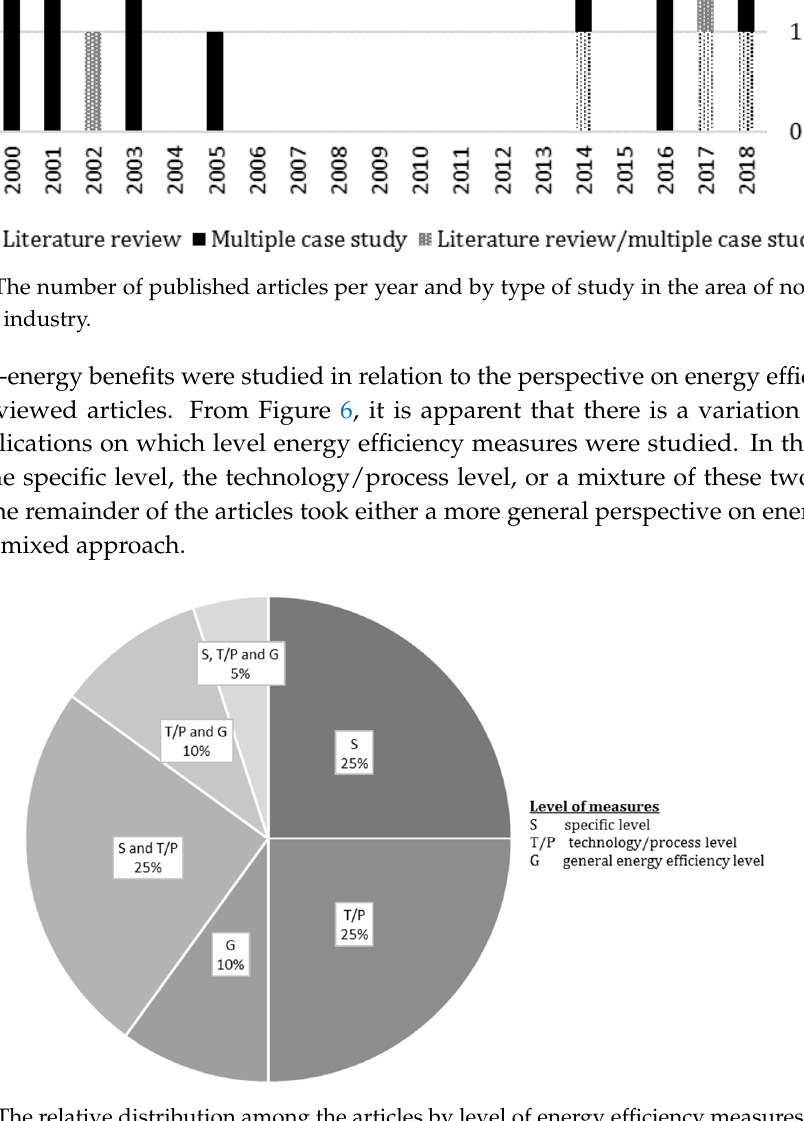
Figure 6. The relative distribution among the articles by level of energy efficiency measures studied.